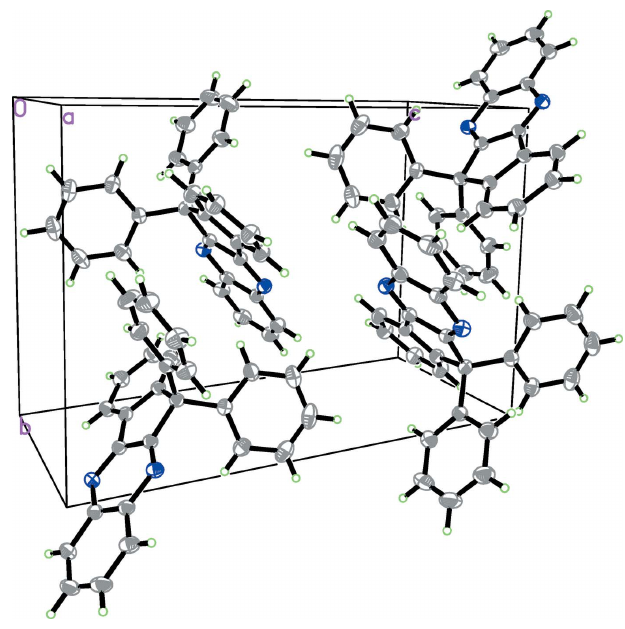
Figure 2 A packing diagram of the title compound.